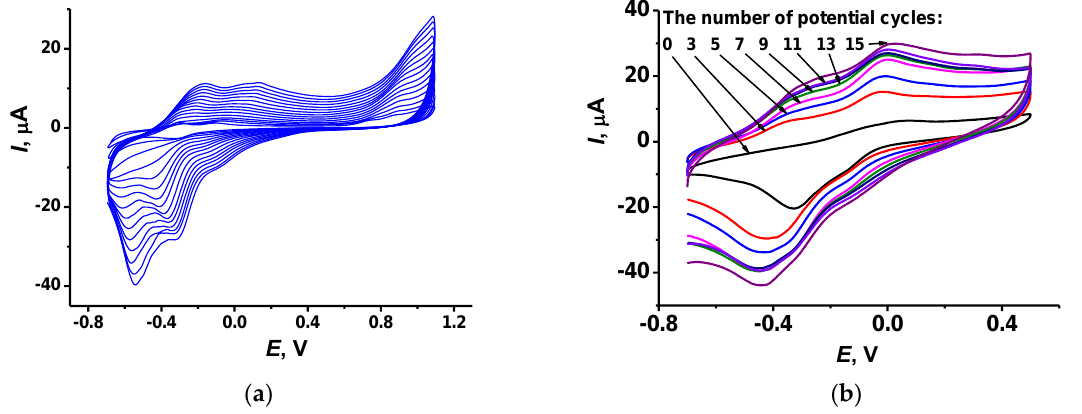
Figure 4. ( a ) An example of cyclic voltammograms recorded on screen-printed electrodes covered with CB and adsorbed P[5]A in the mixture of 0.1 mM MB and 0.1 mM thionine during their electropolymerization; ( b ) one cycle voltammograms recorded in working buffer with no dye monomers on the screen-printed electrodes modified with CB + P[5]A and polymerized MB and thionine, differing in the number of electropolymerization cycles performed. Measurements in 0.01 phosphate buffer + 0.1 M KCl, pH = 7.0, 100 mV/s.